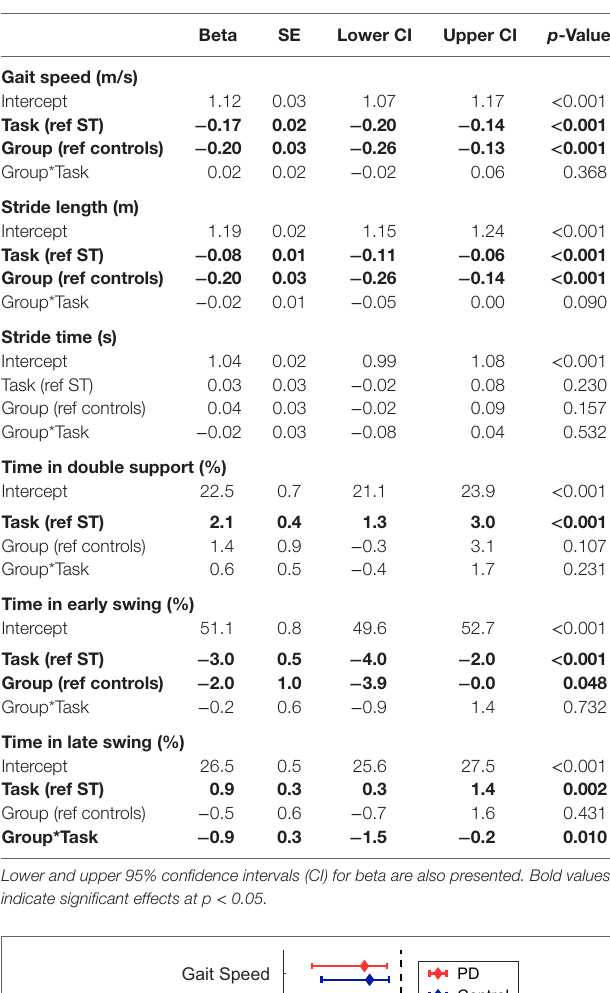
Table 3 | Results from the linear mixed models for each stability measure.